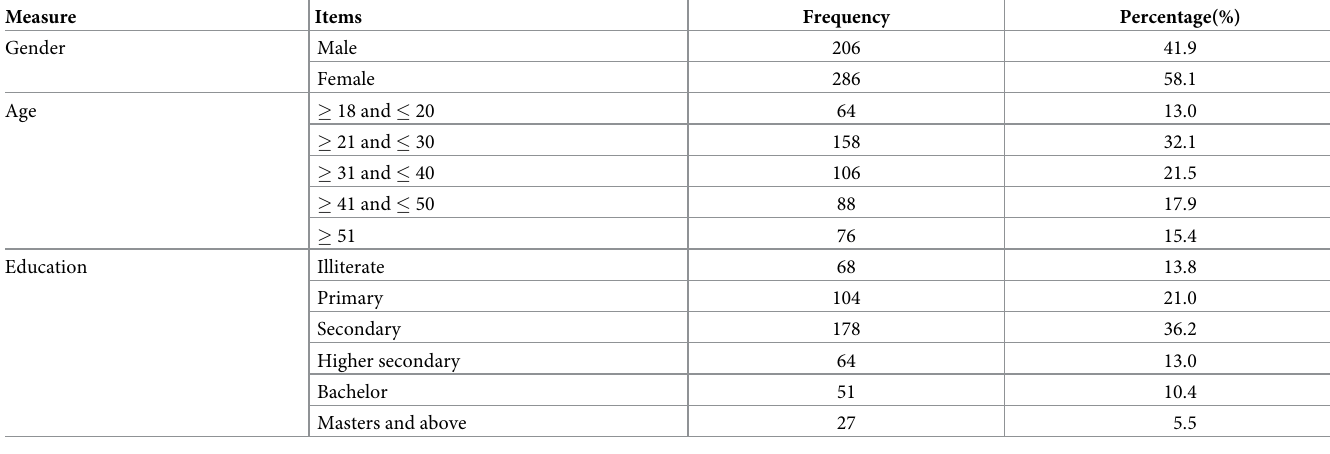
Table 1. Demographic characteristics of the